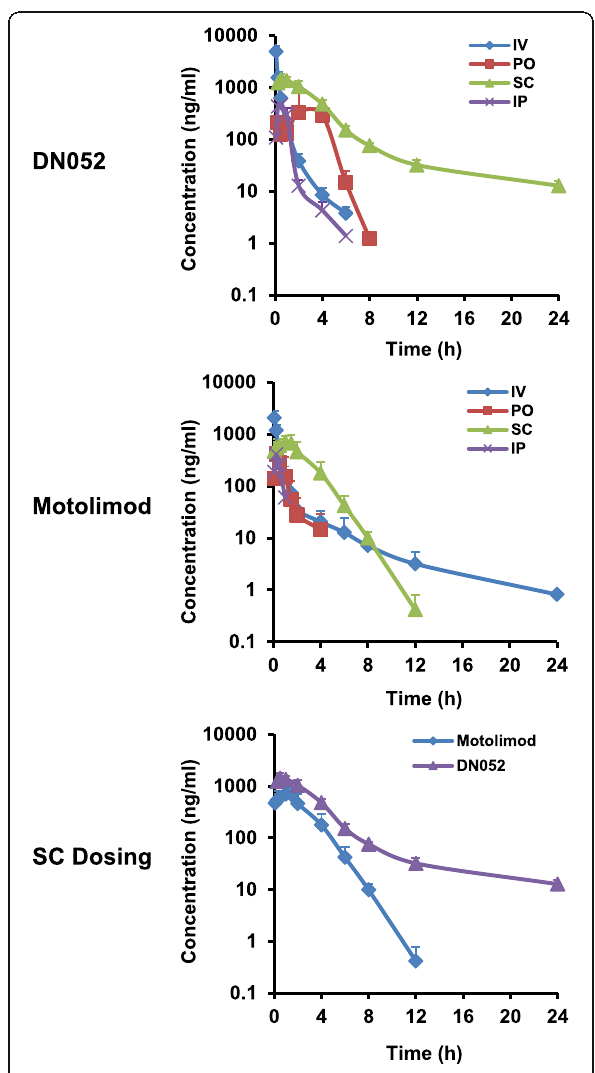
Fig. 2 Comparison of PK with different dosing routes. DN052 and motolimod were iv, ip, sc or po administered to Sprague Dawley rats, respectively. Overall, sc appeared to have better PK than the other dosing routes for DN052. DN052 showed superior PK profile than